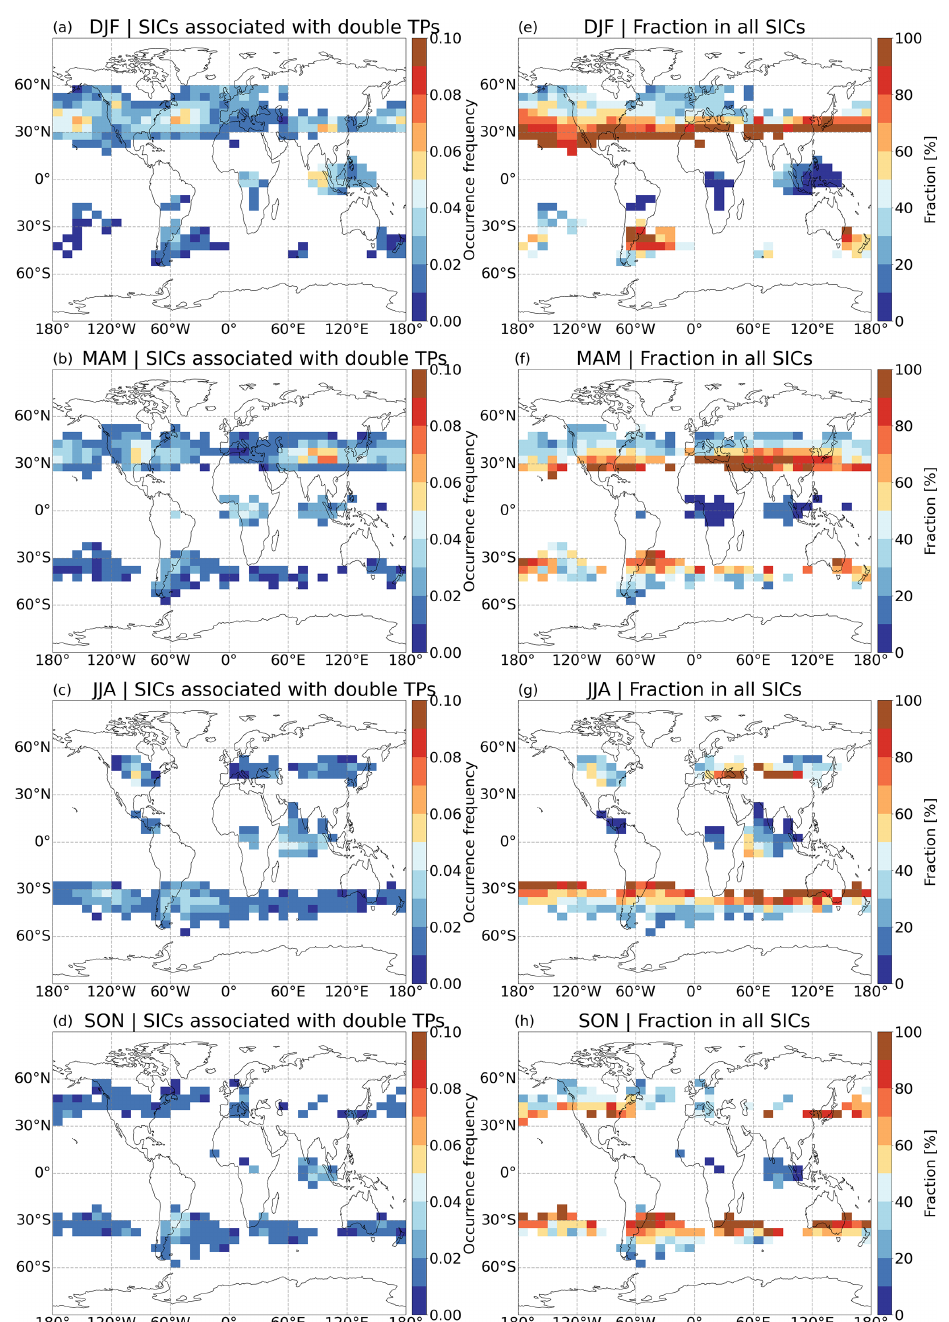
Figure 3. Occurrence frequencies of SICs associated with double tropopauses with respect to all profiles (a–d) , and the fraction of SICs associated with double tropopauses to total SICs (e–h)